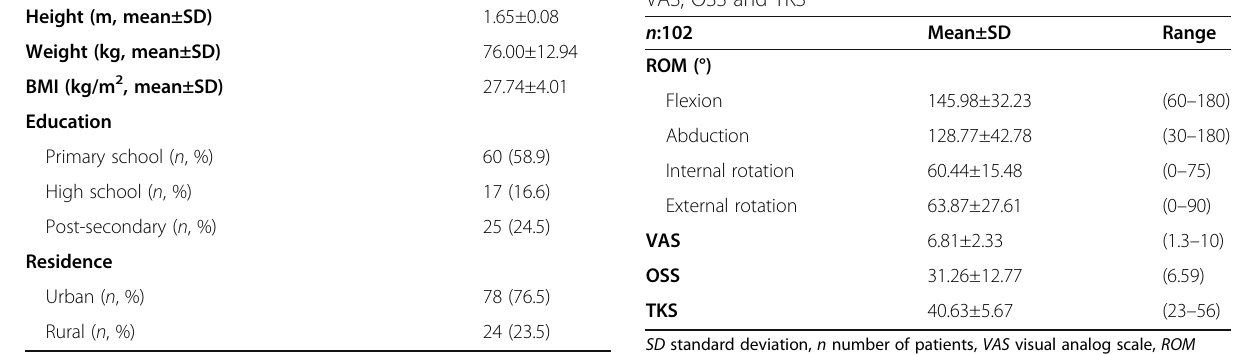
Table 3 Average values (standard deviation, min-max) for